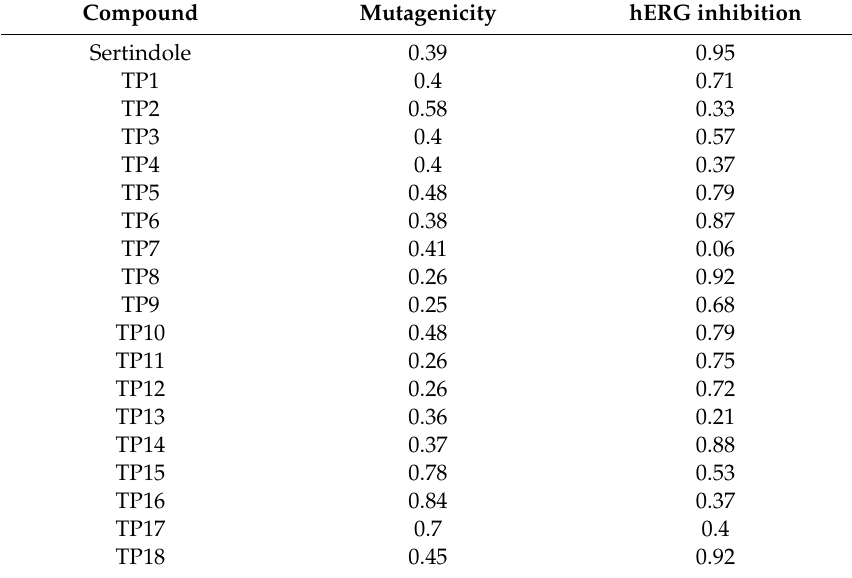
Table 4. Mutagenicity and hERG inhibitory potential of sertindole and its TPs. Compound Mutagenicity hERG inhibition Sertindole 0.39 0.95 TP1